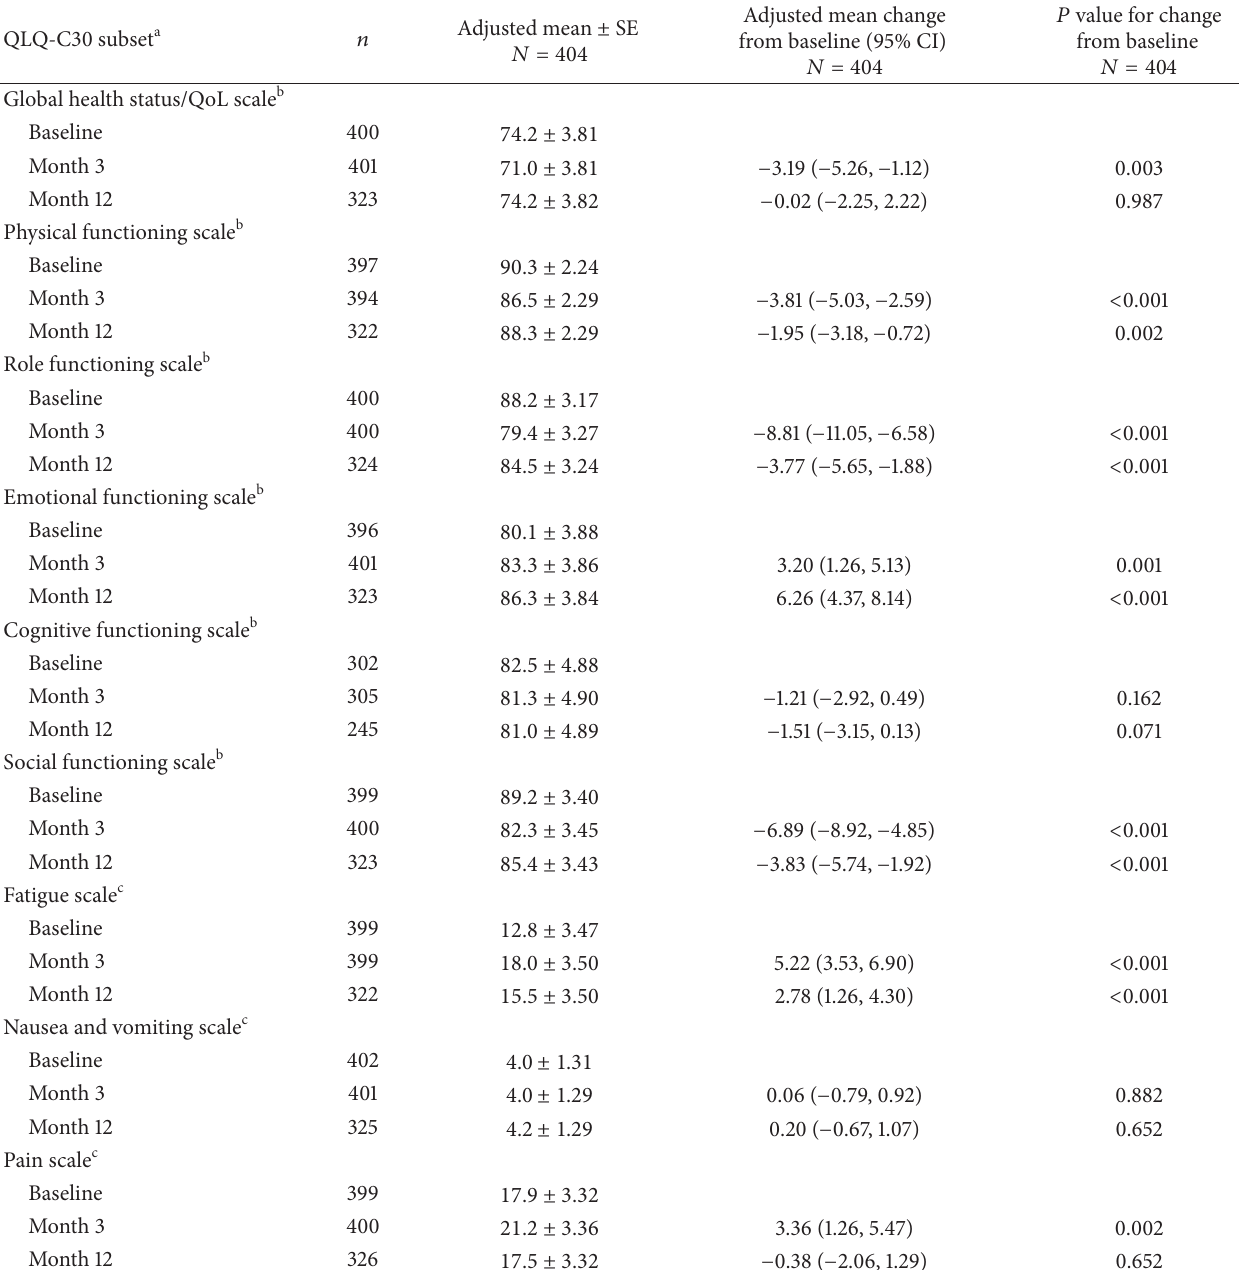
Table 4: Change from baseline in QLQ-C30 scales (FAS population, observed